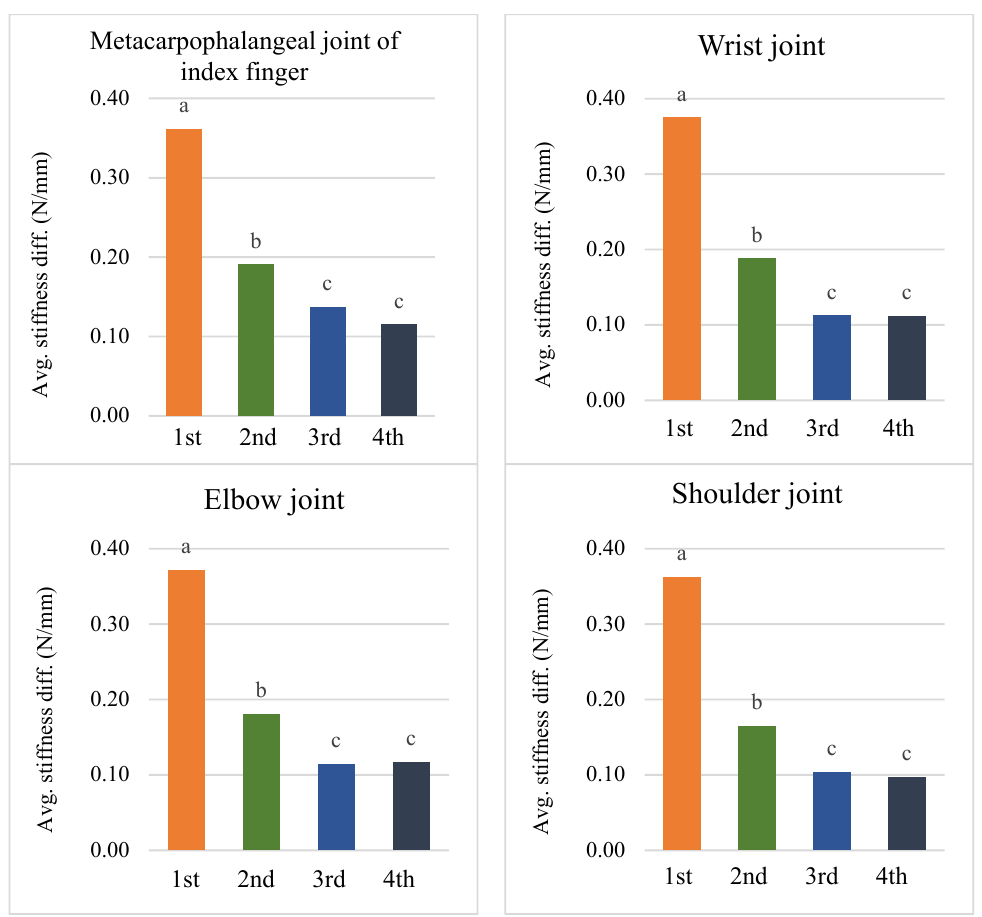
Figure 7. Average palpation speed of four pivot joints (mean ± standard error).